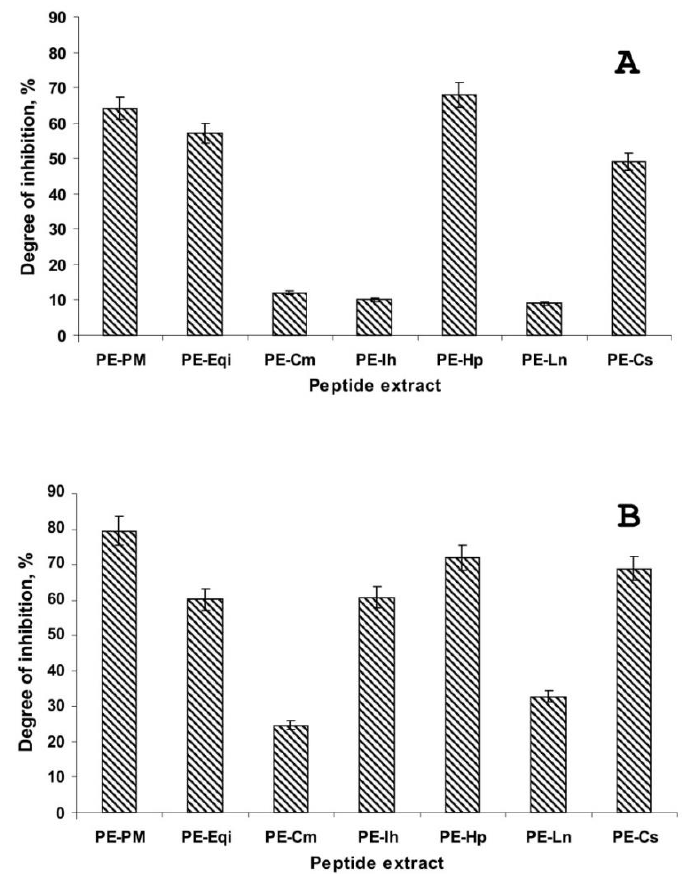
Figure 1. The antimicrobial activity of the plant peptide extracts against Phytophthora infestans by optical microscopy: ( A )—indirect germination, ( B )—direct germination.